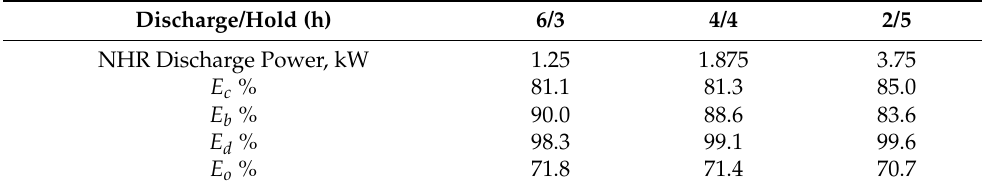
Table 4. Energy efficiency calculation for 7.5 kWh peak shaving tests.